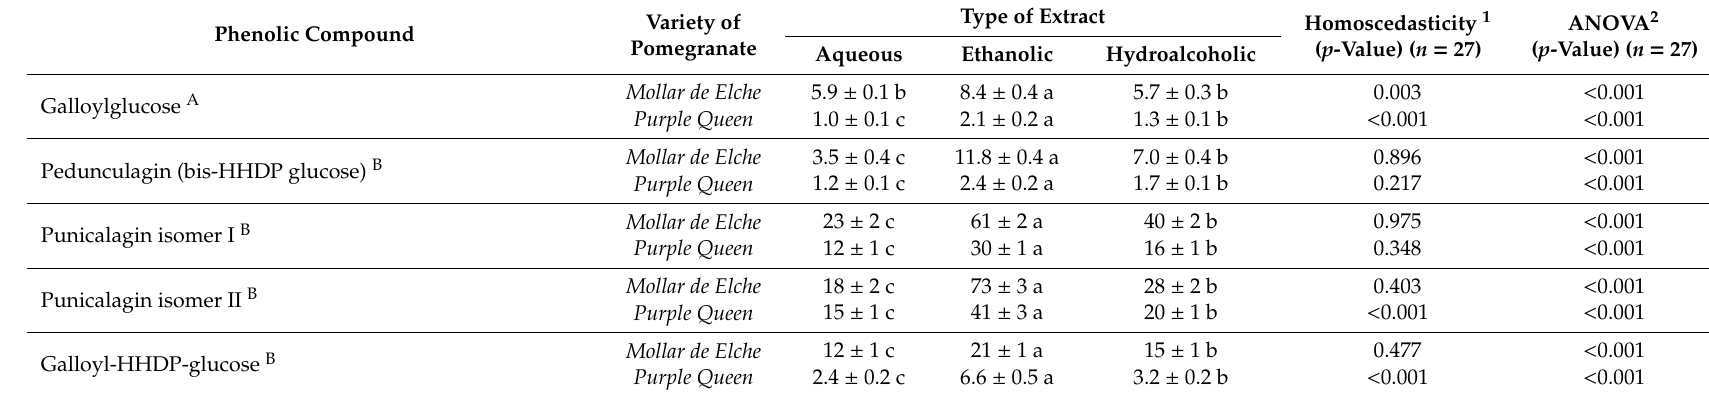
Table 2. Quantification of phenolic compounds (mg / 100 g dry weight) in di ff erent extracts of pomegranate peel of the Mollar de Elche and Purple Queen